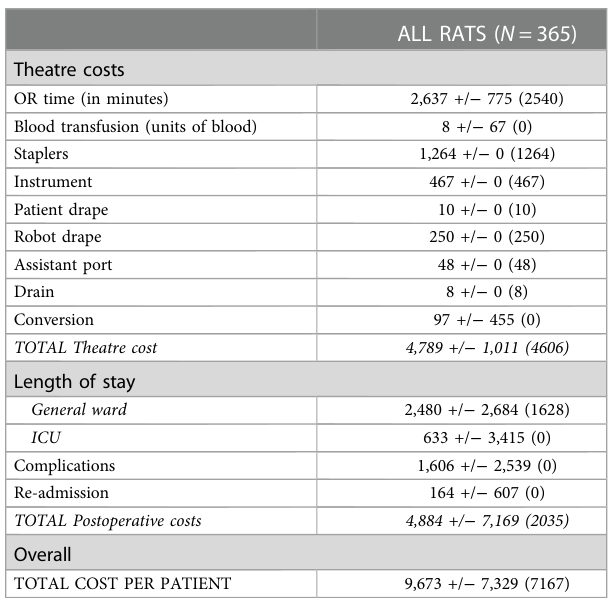
TABLE 2 Costs associated with RATS lung resection. TABLE 4 Patient characteristics of RATS and VATS lung resections.